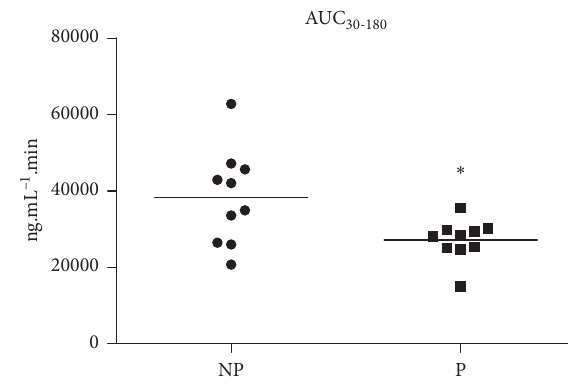
Figure 2: Primaquine (PQ) disposition in nonpregnant (NP) and pregnant (P) rats: areas under the curve (AUC 30-180 ) for PQ (40 mg.kg · bw − 1 ) administered by the oral route (gavage) on GD 21. ∗ (Student’s t -test): p < 0 .